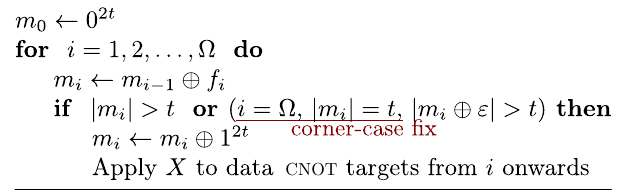
The algorithm deals with each round in the same way except round (cid:2) . When i = (cid:2) and | m case fix effectively flips the rightmost nontrivial flag ε